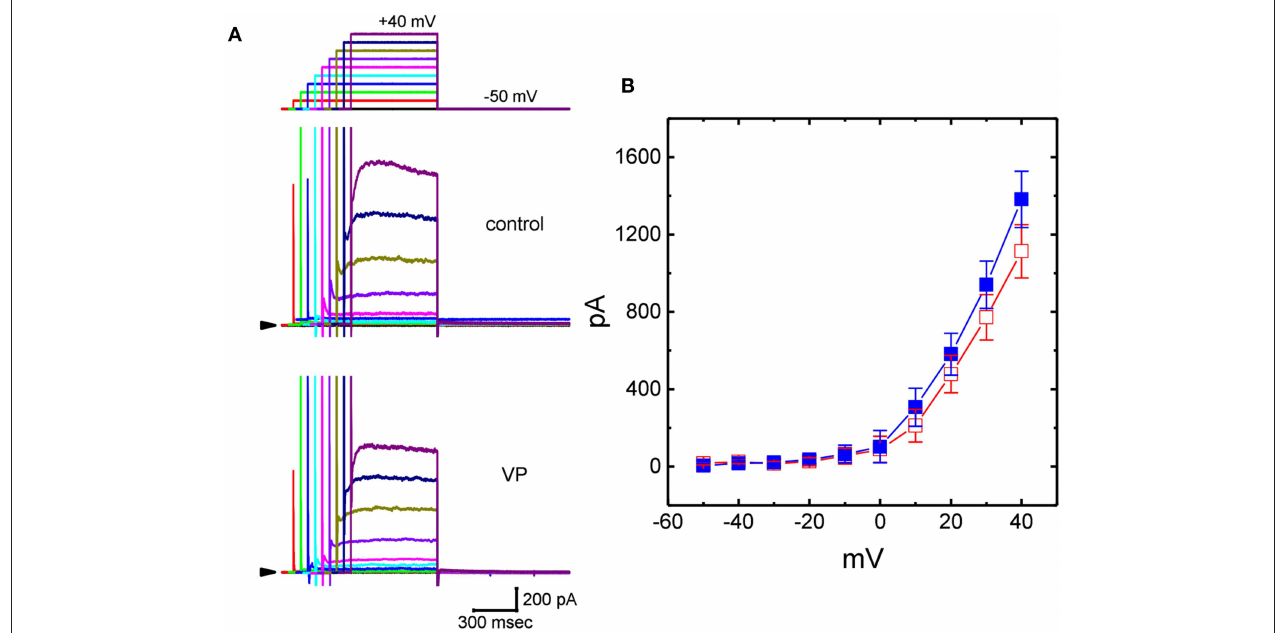
FIGURE 3 | Effects of VP on delayed-rectifier K + current ( I K(DR) ) in GH 3 cells. In these experiments, we bathed cells in Ca 2 + -free Tyrode’s solution containing 1 µ M tetrodotoxin (TTX), and whole-cell currents were recorded by filling the pipette with K + -containing solution. The examined cell was held at − 50mV and a series of depolarizing steps ranging between − 50 and + 40mV was applied [indicated in the uppermost part of (A) ]. (A) Superimposed I K(DR) traces obtained during the control (upper) and cell exposure to 10 µ M VP (lower). Arrowhead in each panel represents the zero-current level. (B) Averaged I-V relationships for I K(DR) obtained with or without the addition of 10 µ M VP (mean ± SEM; n = 13 for each point). Current amplitudes were measured at the end of each depolarizing step. (cid:4) : control; (cid:3) : in the presence of 10 µ M